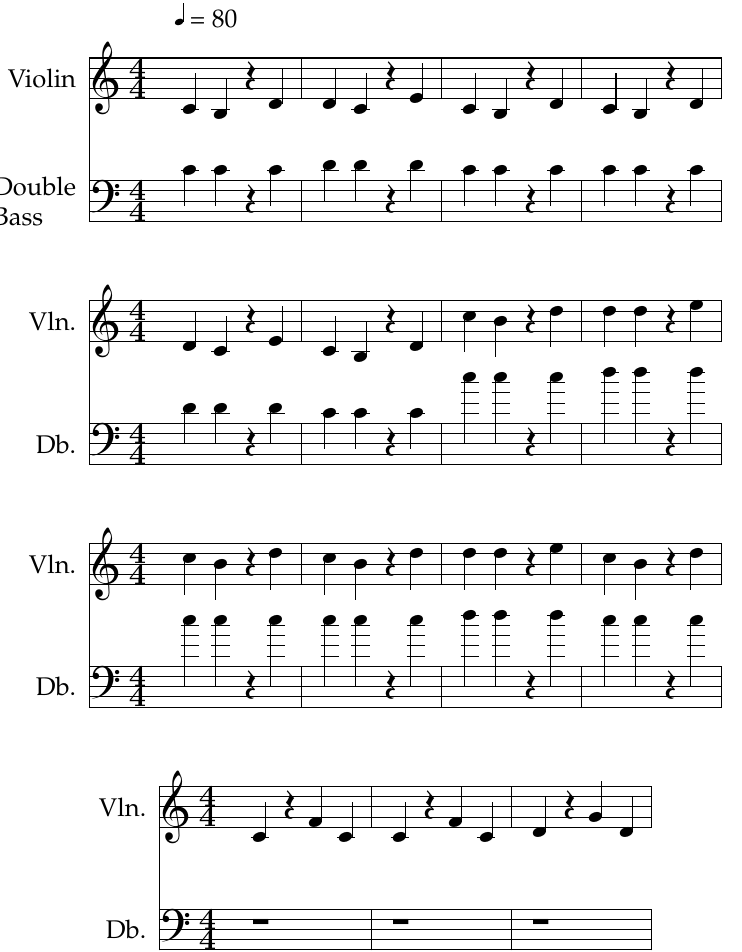
Figure 5. Resulting score from Iteration 4 (see Audio S5).